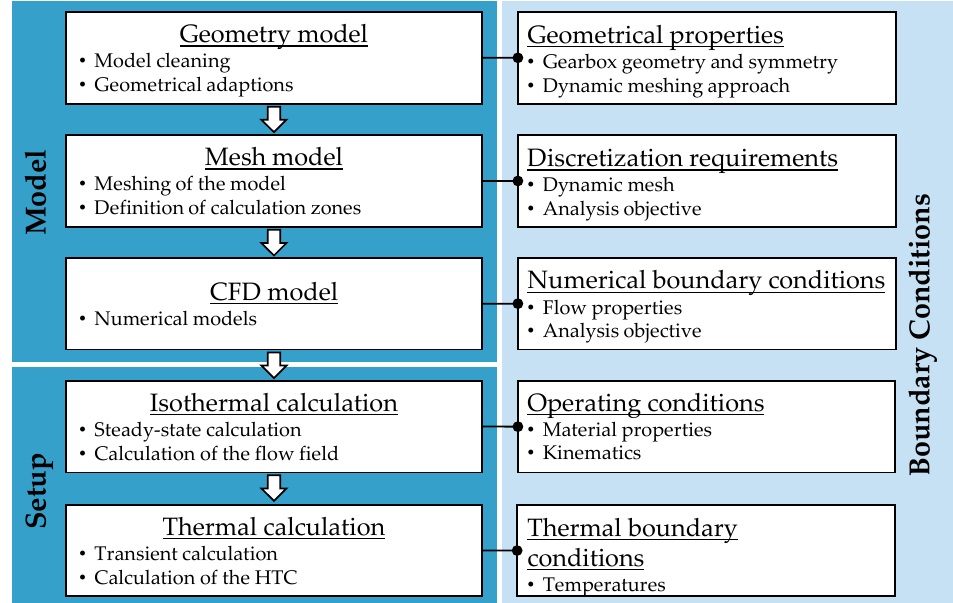
Figure 4. Simulation methodology for the thermal CFD simulations of the gearbox.